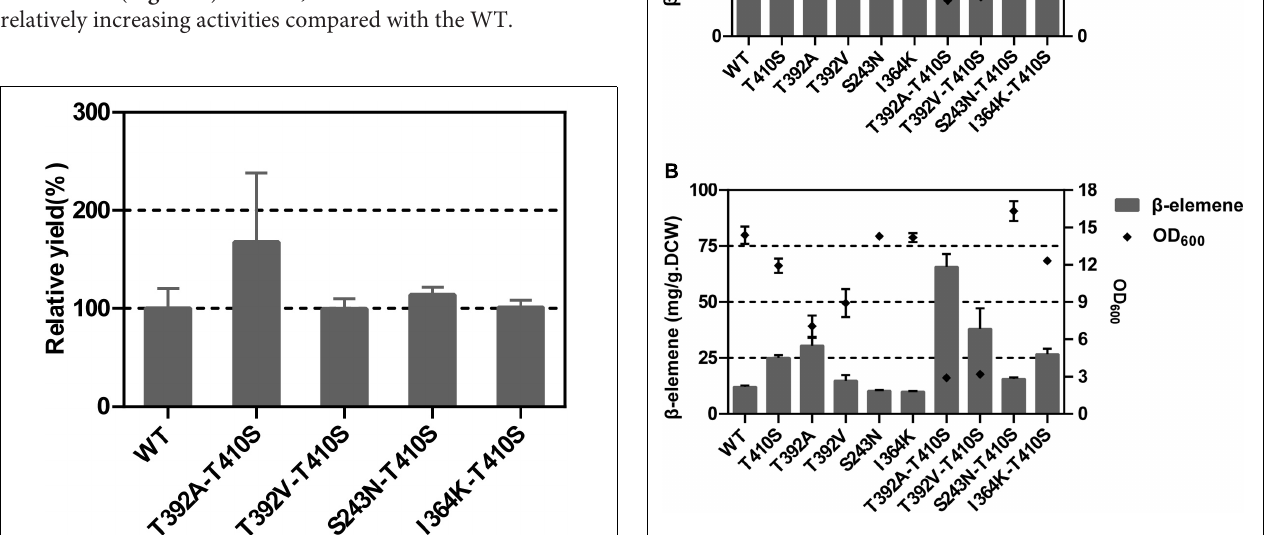
Frontiers in Plant Science |